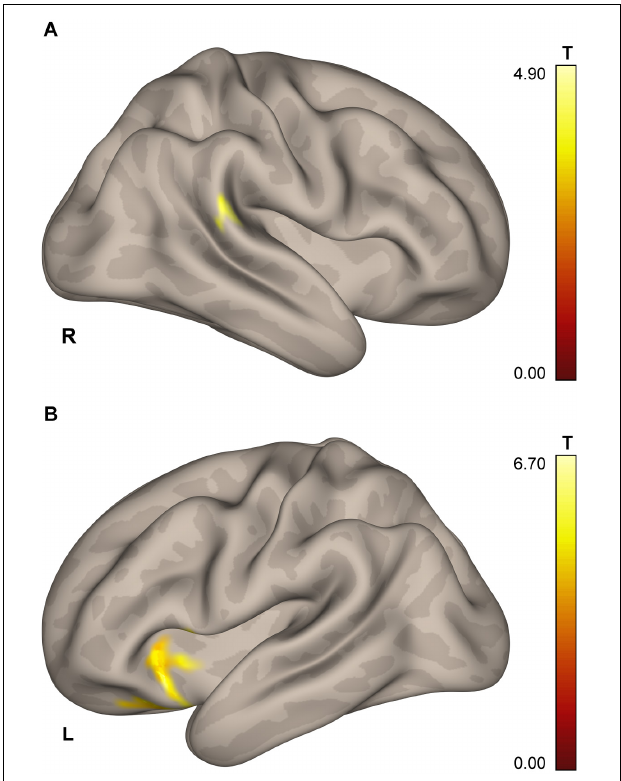
FIGURE 3 | Results of the ICC and follow-up seed-to-voxel analysis. (A) Area in the lower portion of the right posterior supramarginal gyrus demonstrating higher connectivity with the rest of the brain for cosmonauts vs. controls, post- vs. pre-flight, plantar stimulation vs. rest, as revealed by the ICC analysis (cluster-wise FDR correction, q < 0.05, p < 0.05; voxel-wise cluster-defining threshold, p < 0.001 uncorrected). (B) Cluster in the left orbitofrontal cortex, insula and operculum, demonstrating correlation between the severity of space motion sickness and post- vs. pre-flight, plantar stimulation over the resting baseline difference in functional connectivity, with the seed in the rpSMG area shown in the (A) . Results are shown after the cluster-wise FDR correction, q < 0.05, p < 0.004 = 0.05/12; voxel-wise cluster-defining threshold, p < 0.001